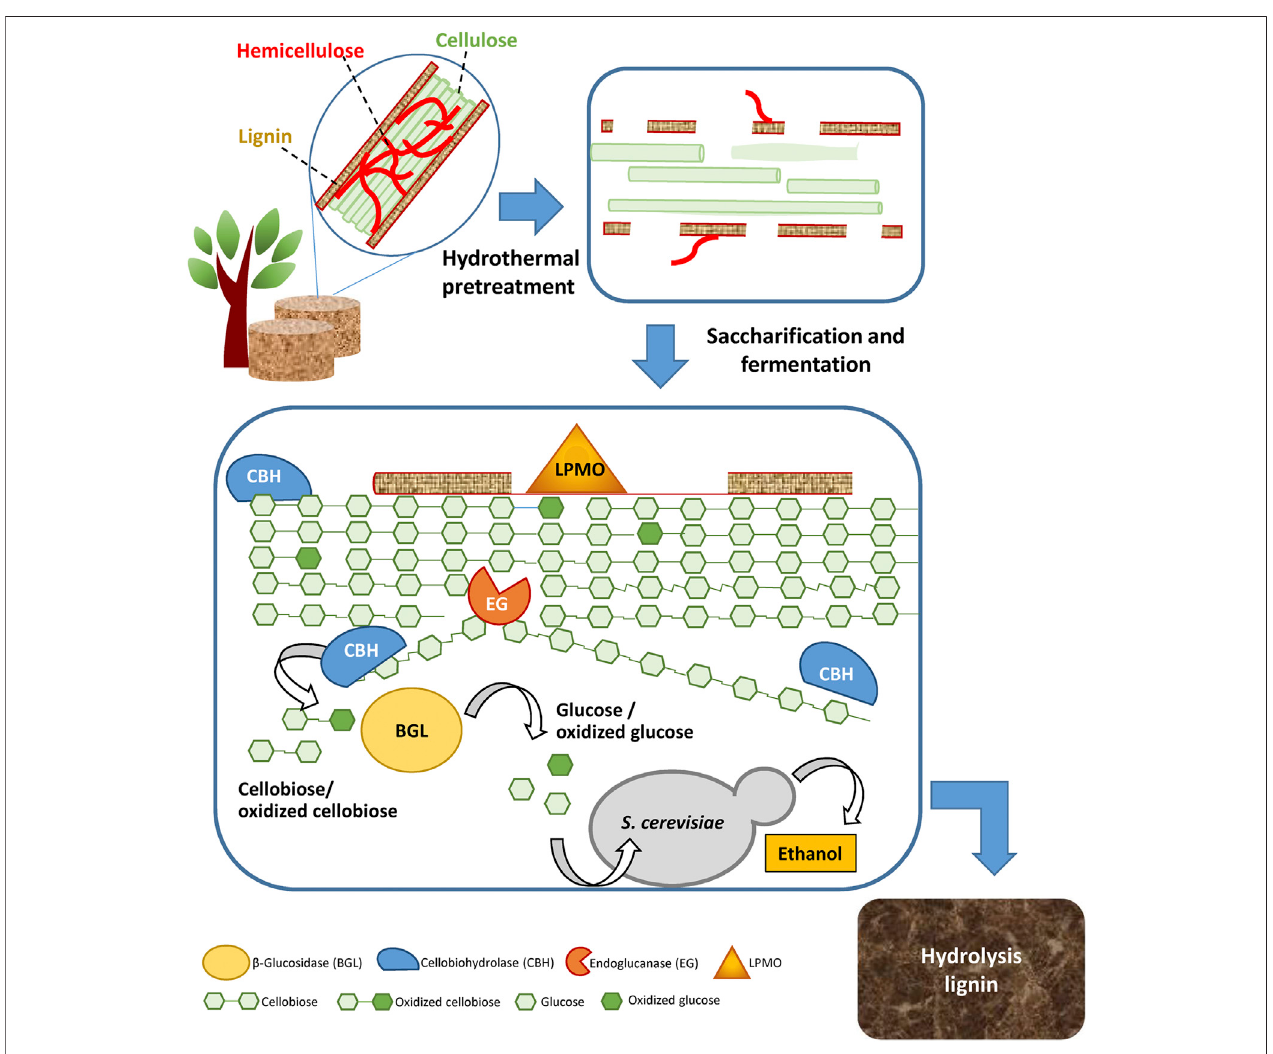
FIGURE 1 | Schematic view of pretreatment, enzymatic sacchari fi cation, and fermentation of sugars from lignocellulosic biomass.